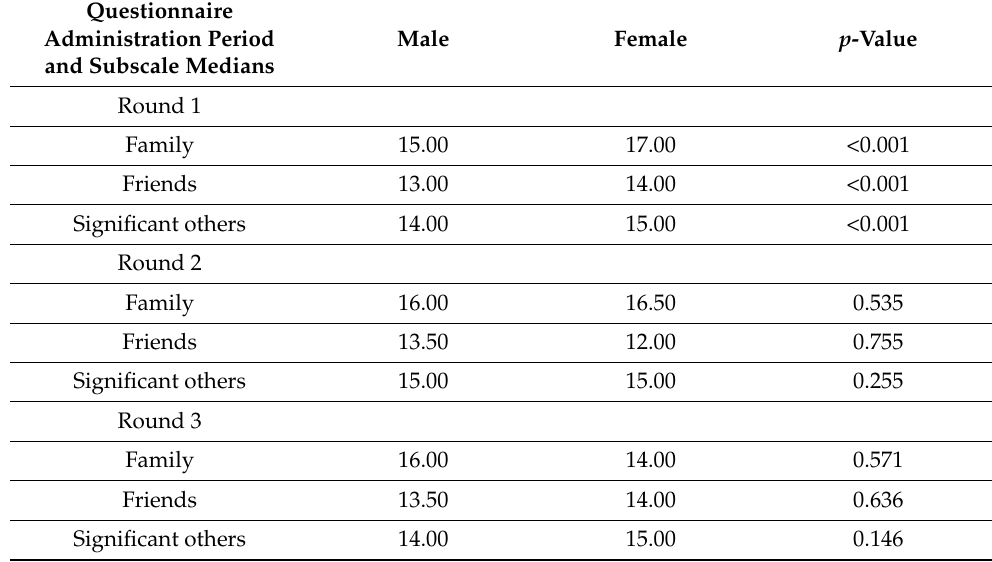
Table 2. Gender differences in perceived social support subscales among Hungarian students.